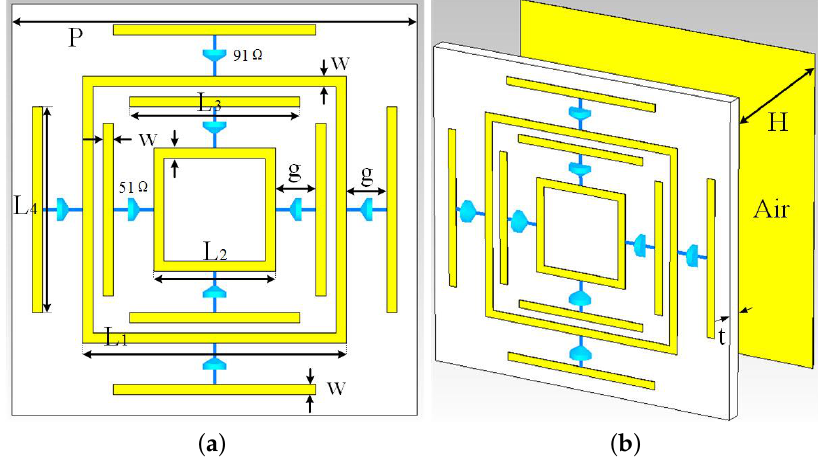
Figure 1. Unit structure parameters of the designed absorber. ( a ) Front view; ( b ) Oblique